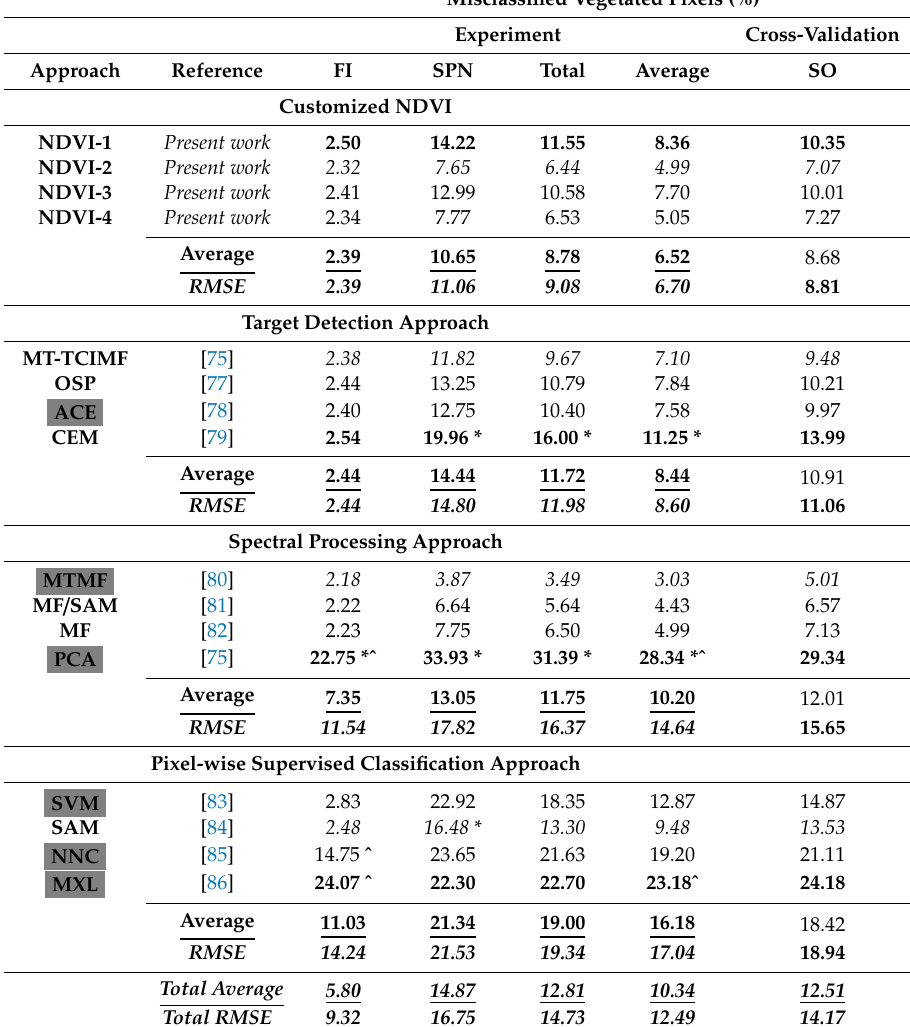
Table 5. Quantitative evaluation of various feature extraction methods for extracting vegetation from Fisher Island (FI), Stornes Peninsula (SPN), and cross-validation with Schirmacher Oasis (SO) in terms of misclassified vegetated pixels (%). The lowest ( italics ) and highest (bold) values in each local column are highlighted. The column-wise average values are in bold and underlined. Methods that cause overall overestimation of vegetation are highlighted with the grey background colour. Global outliers (with respect to all 16 methods) are highlighted with ˆ marks while local outliers (with respect to the four methods in the approach) are highlighted with *